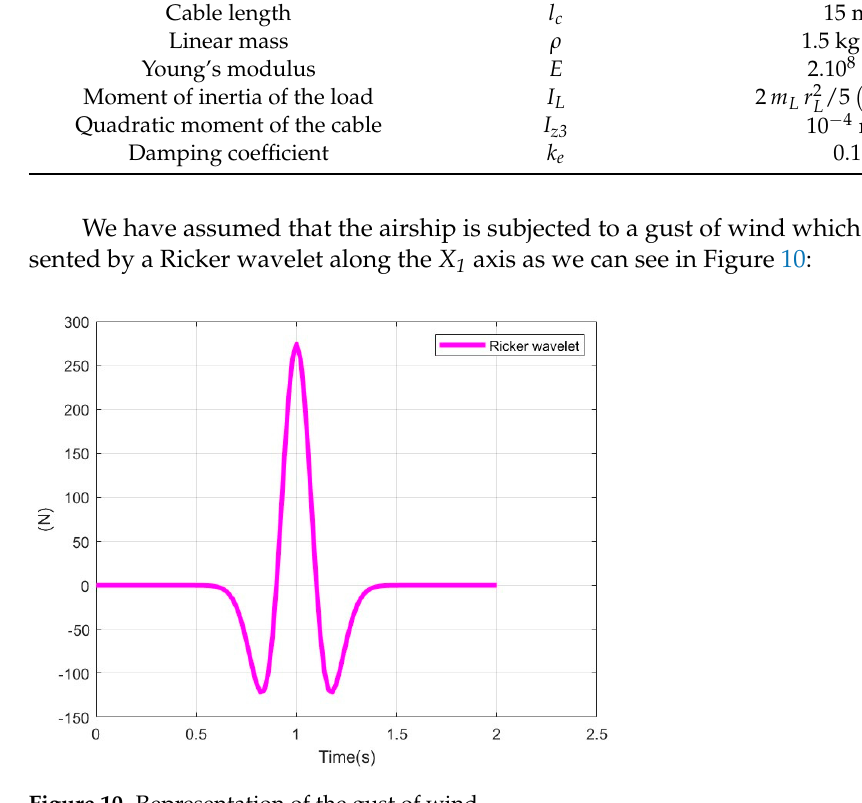
Table 1. Characteristics of the different elements of the system.